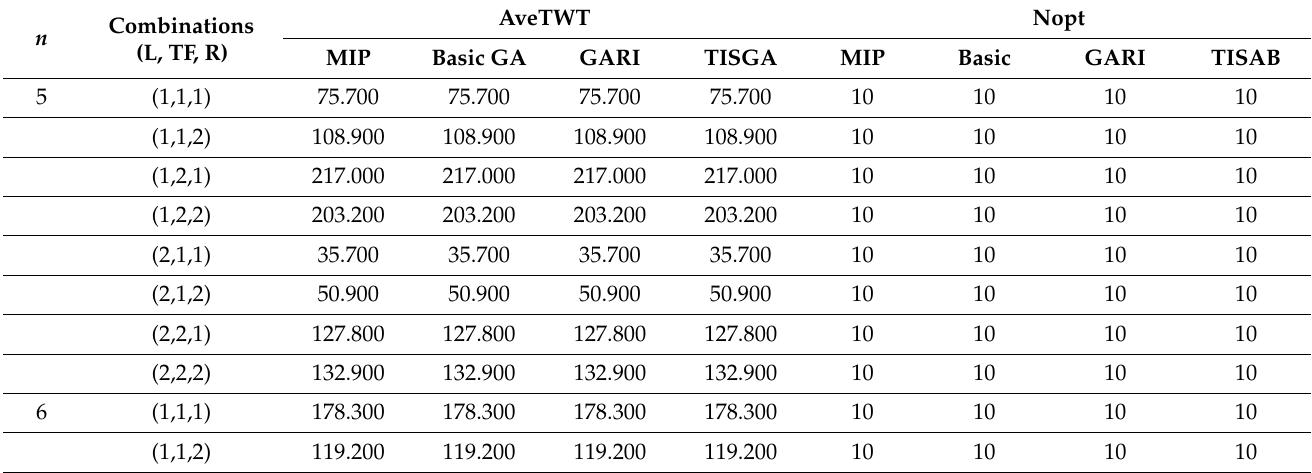
Table 8. Comparison of results for MIP and GAs for small-sized